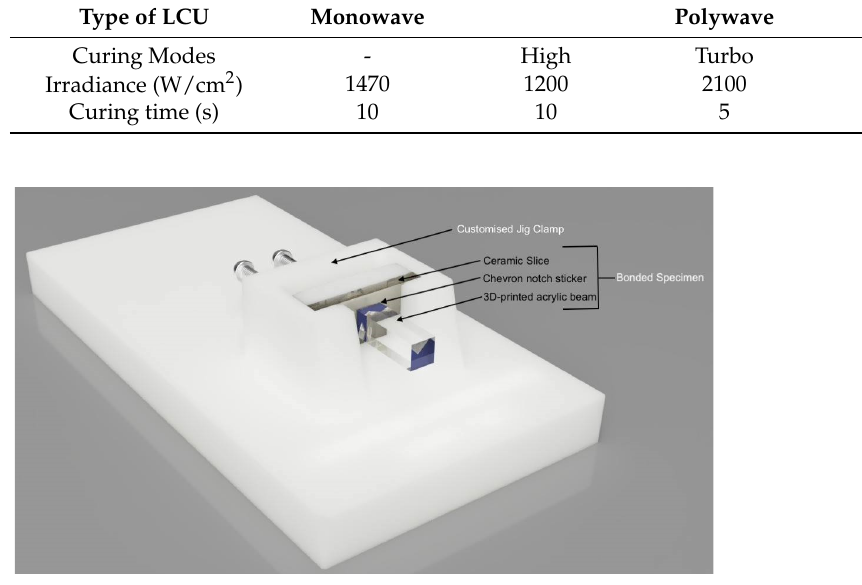
Figure 2. Image showing assembly of bonded specimen to the customised jig clamp before being loaded by a universal testing machine.